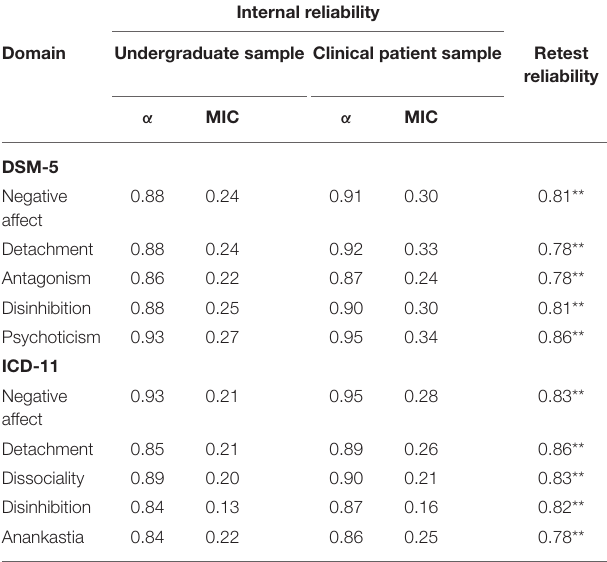
TABLE 2 | Internal reliability and retest reliability of DSM-5 and ICD-11